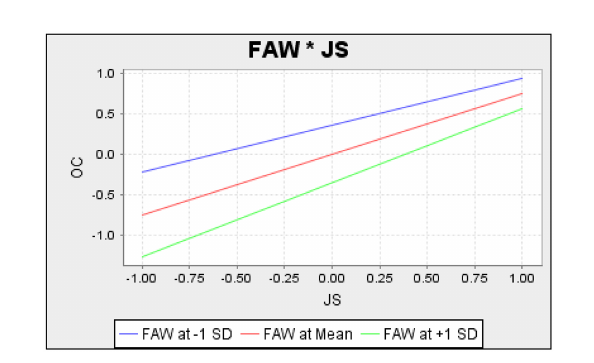
FIGURE 3 Moderation effect of fun at work between job satisfaction and organizational commitment.